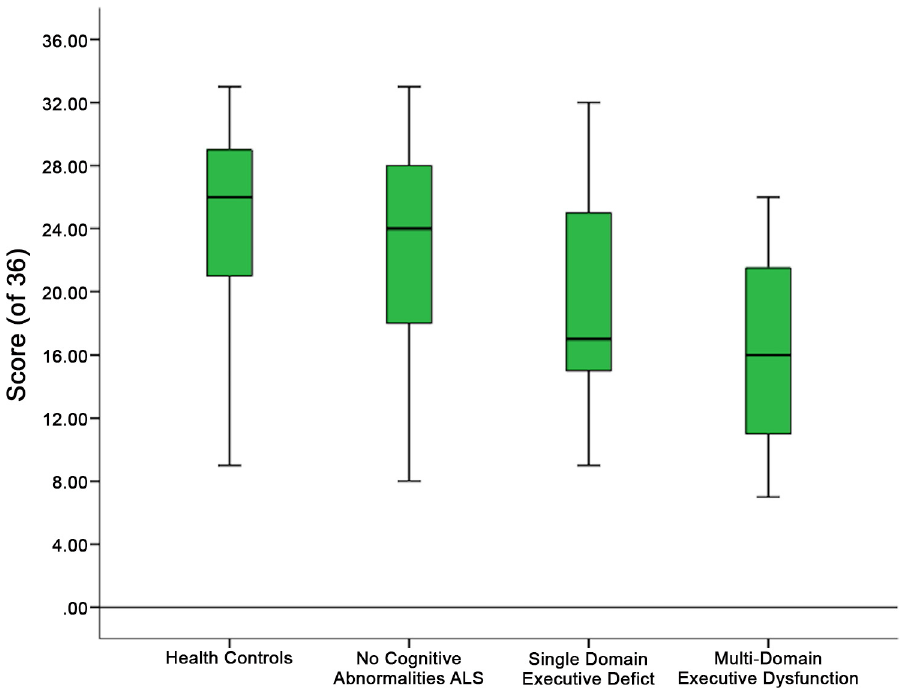
Fig 1. Distribution of Scores on the RMET. Patient and Control Performance on the Reading the Mind in the Eyes Test, stratified by cognitive categorisation.